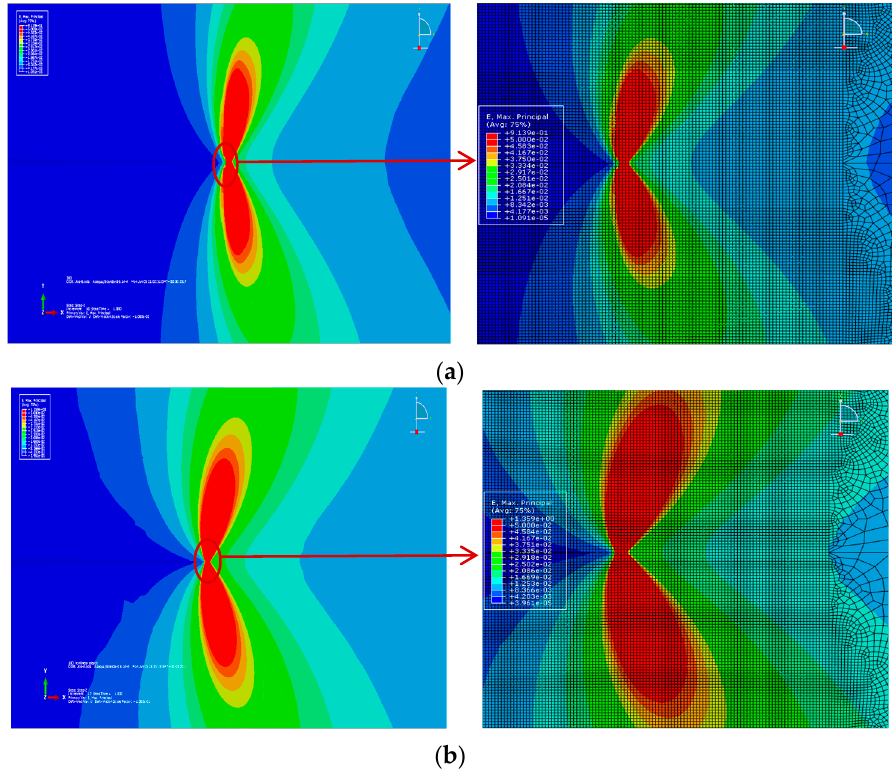
Figure 2. Strain field at the crack tip: ( a ) Linear elastic and perfect plastic; and ( b ) Nonlinear cyclic stress-strain relationship. Table 1. Mechanical properties used in the finite element (FE) analysis.